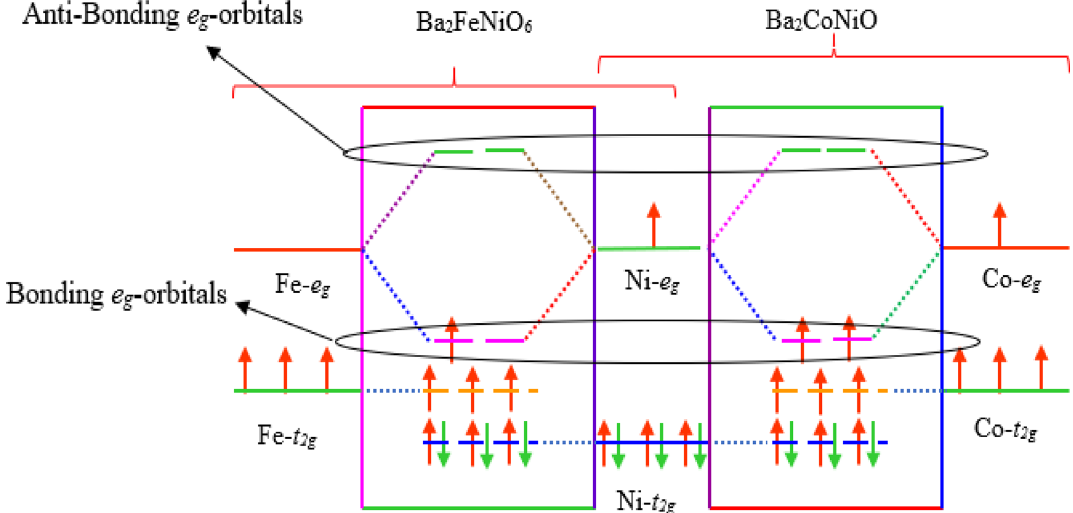
Figure 6. Molecular orbital splitting and formation of hybridized bonding and anti-bonding